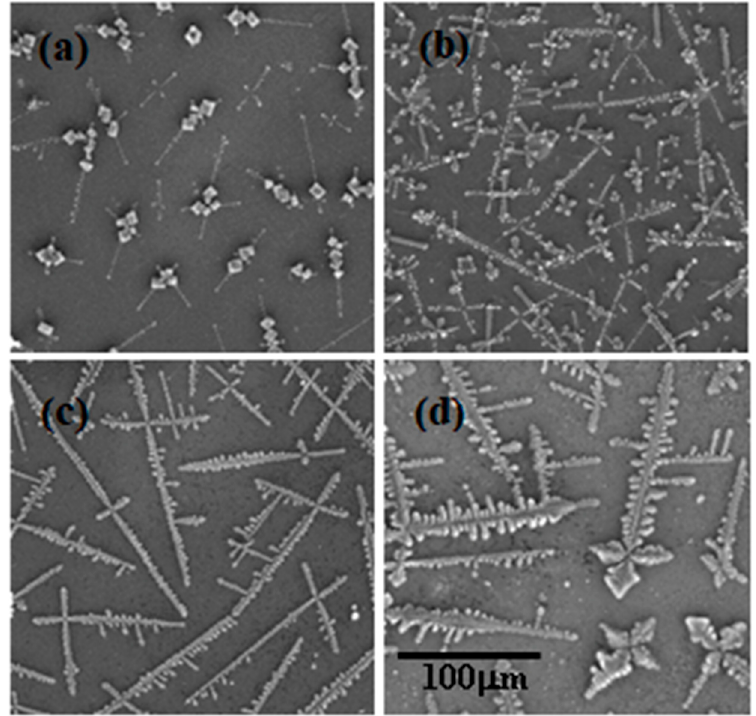
Figure 6. SEM images of dried droplets of PDADMAC–SLMT mixtures depicting the variation in NaCl crystal size with SLMT concentrations of: ( a ) 2.9 µM, ( b ) 29 µM, ( c ) 0.29 mM, and ( d ) 2.9 mM. the growth of dendritic-like structures appears favored.